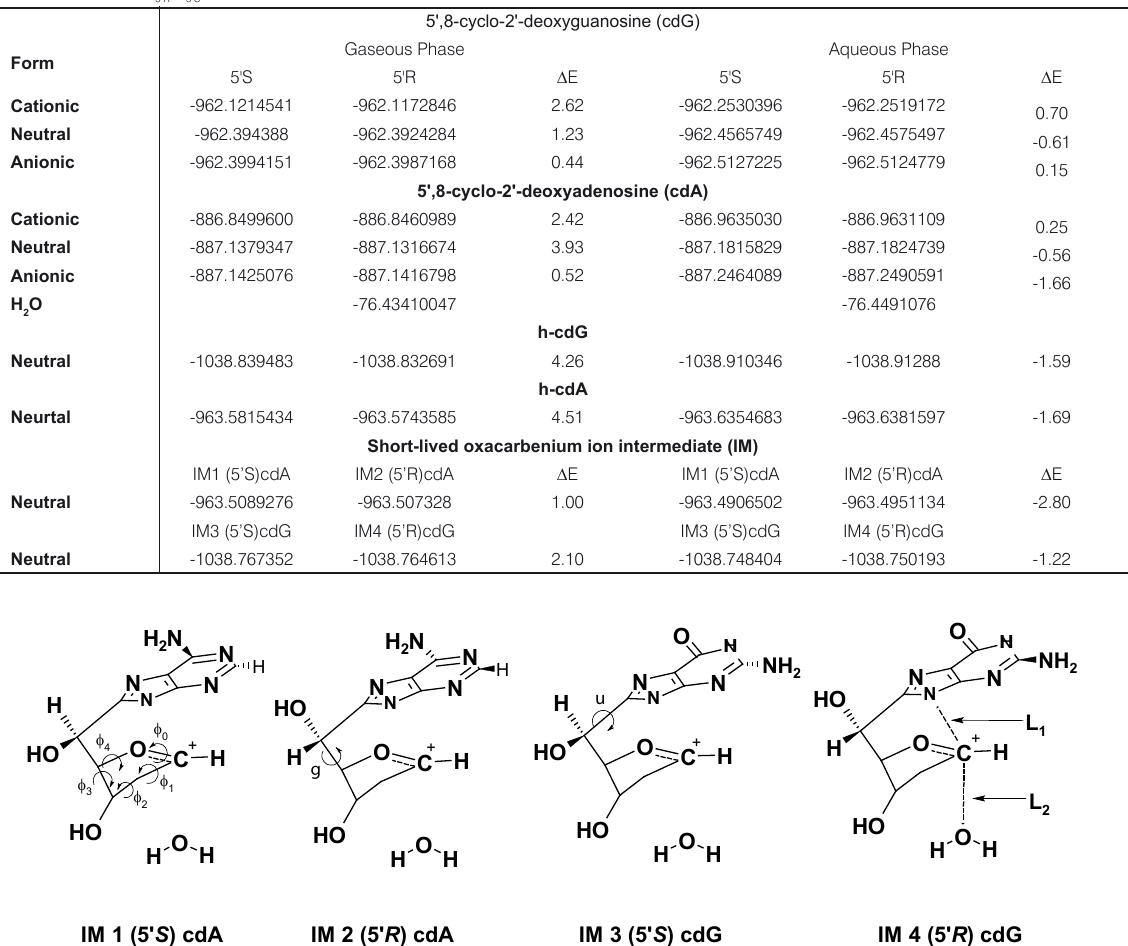
Table 2. Zero-point energy corrected Gibbs Free Energies of the 5’,8-cyclo-2’-deoxynucleoside, short-lived oxacarbenium ion intermediates (IM 1-4), related hydrolysis products (h-cdA, h-cdG) in Hartree and the energetic difference between their suitable diastereomeric forms ( ∆ E=E -E ) in kcal mol -1 (1 Hartree = 627.5095 kcal mol -1 5’R 5’S